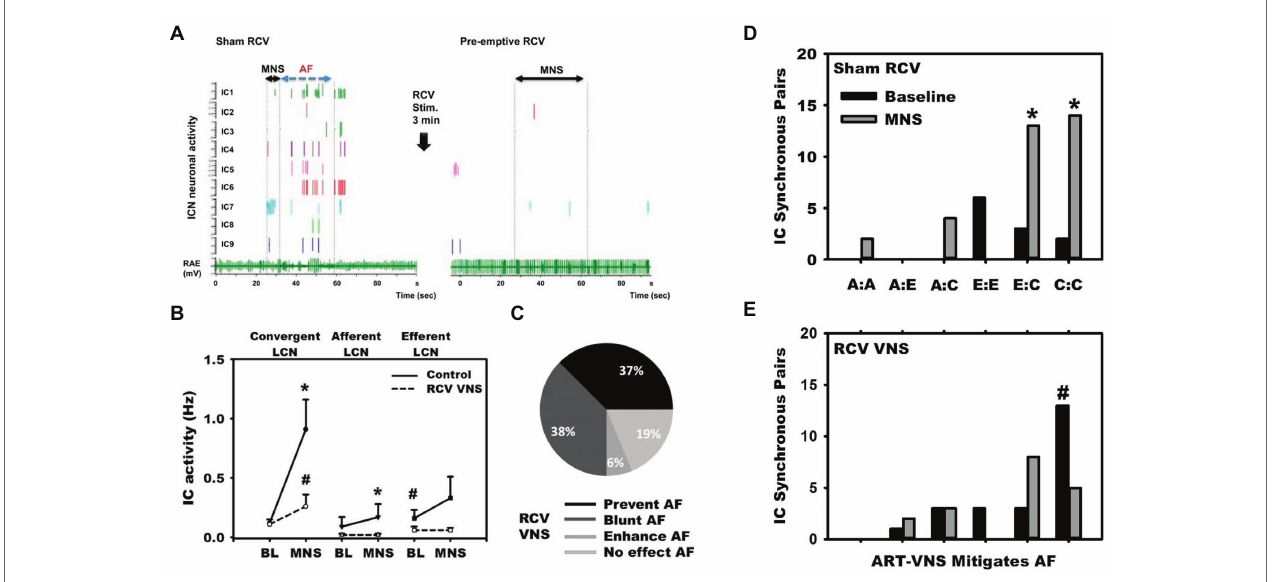
FIGURE 6 | Vagal nerve stimulation targets LCNs within the ICNS to reduce arrhythmogenesis. (A) In response to mediastinal nerve stimulation, activity within the RAGP significantly increased and transient periods of AF were induced. (B) Increased neural activity during mediastinal nerve stimulation was primarily driven by increased activity of LCNs. (C) VNS mitigated neural activity changes in response to mediastinal nerve stimulation and prevented or blunted atrial arrhythmogenesis. (D) and (E) Intrinsic cardiac neurons were classified as afferent (A) , efferent (E) , or convergent (C) . Mediastinal nerve stimulation resulted in increases in synchrony between efferent to convergent pairs and convergent to convergent pairs, while preemptive right cervical vagus nerve stimulation prevented such. Adapted from Salavatian et al. (2016). (B) : * p < 0.05 from baseline; # p < 0.05 from control (sham VNS). (D) and (E) : * p < 0.05 from baseline; # p < 0.01 sham to RCV VNS state.